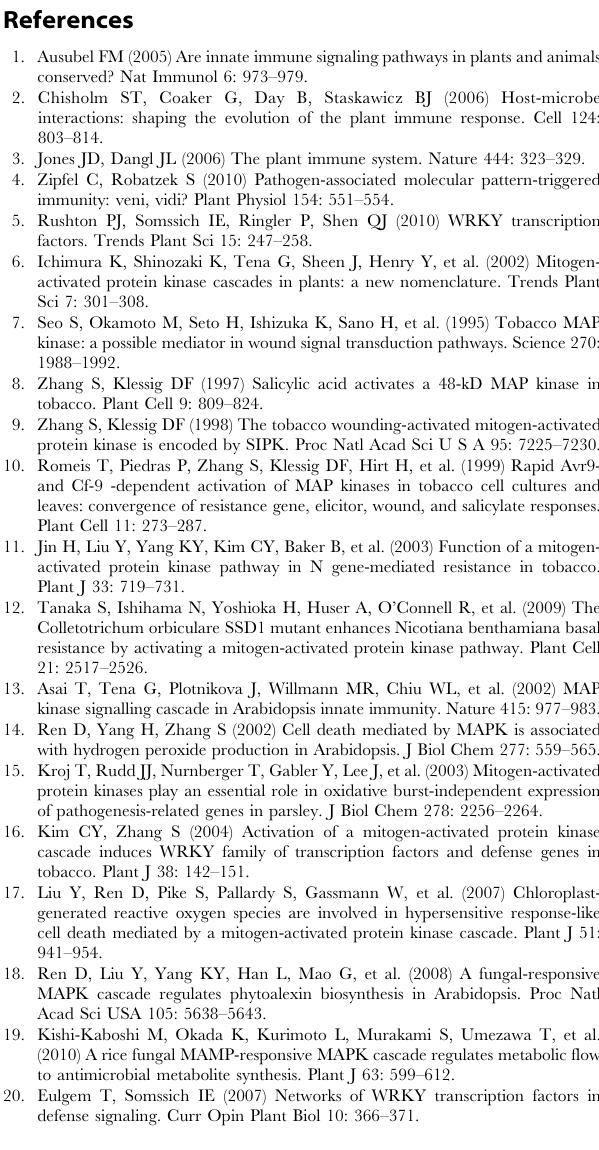
Table S1 Plasmids used in this study. Table S2 Primers used for the plasmid construction. Table S3 Primers used for qRT-PCR analysis.